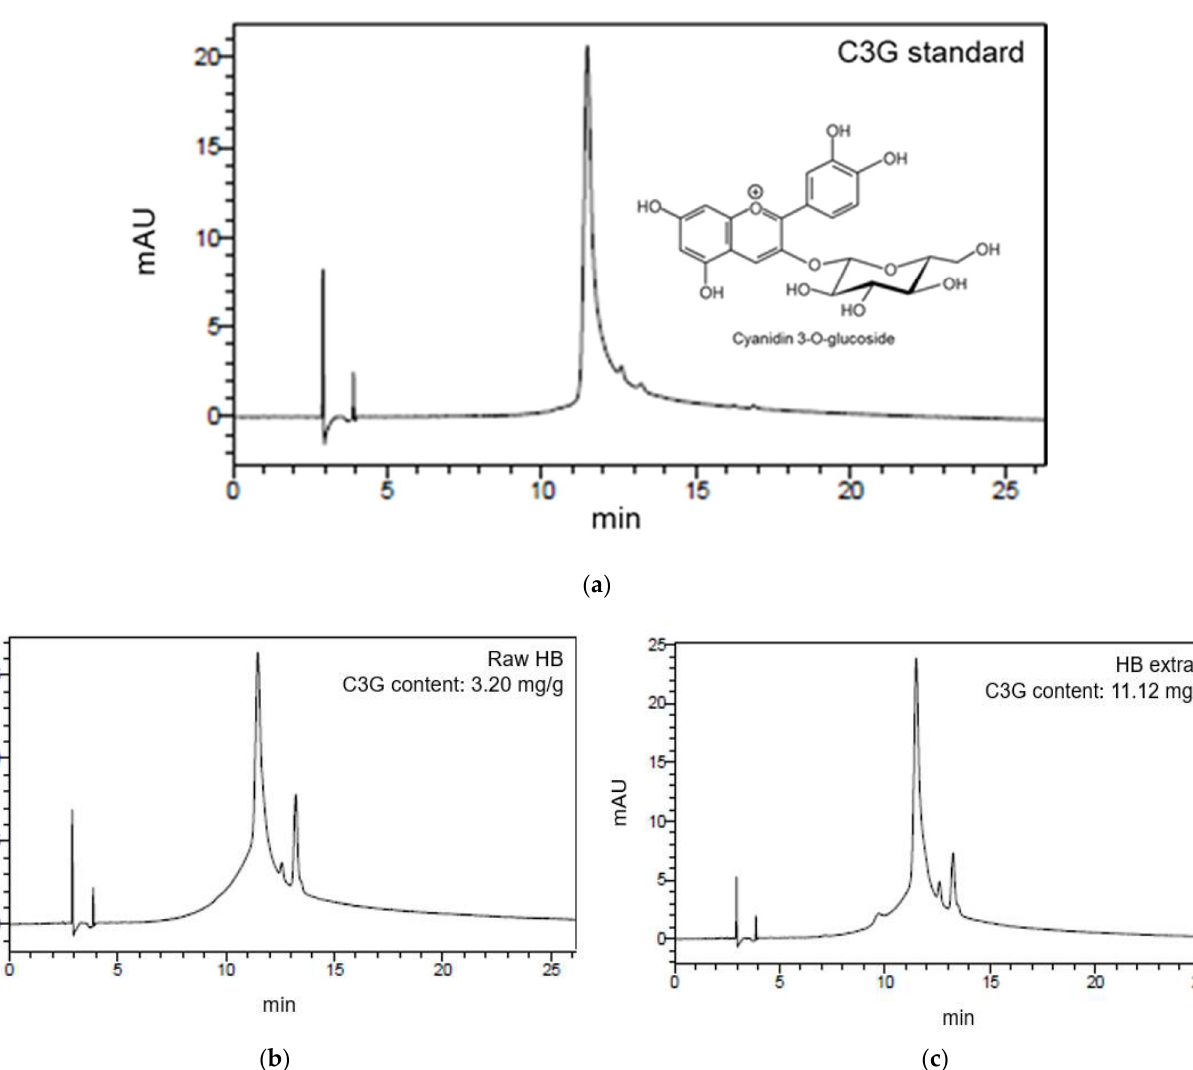
Figure 2. High performance liquid chromatography (HPLC) analysis results. ( a ) C3G standard; ( b ) Raw HB; and (c) HB extract.